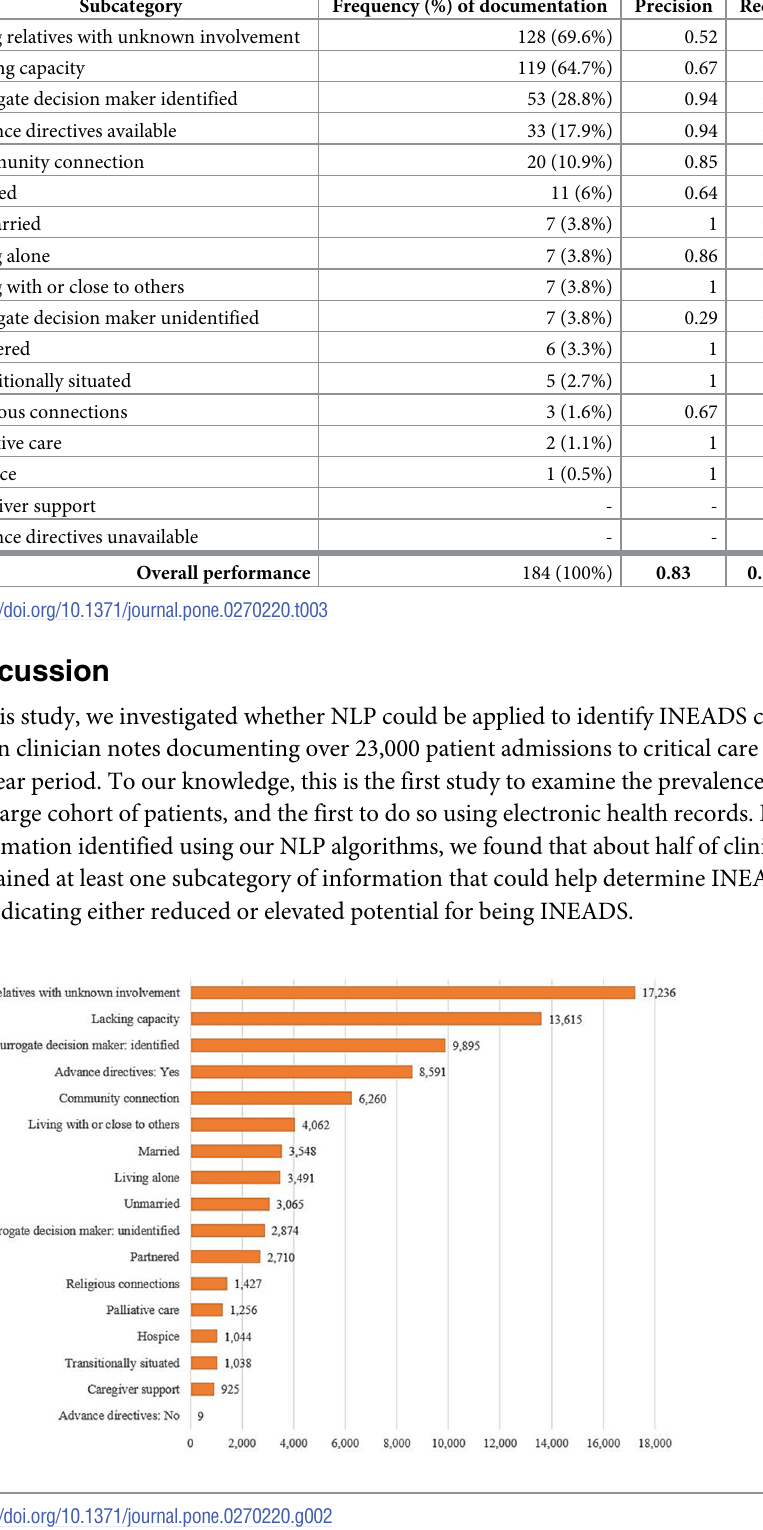
Table 3. Evaluation of natural language processing algorithm performance through gold-standard manual review (n = 300 clinical